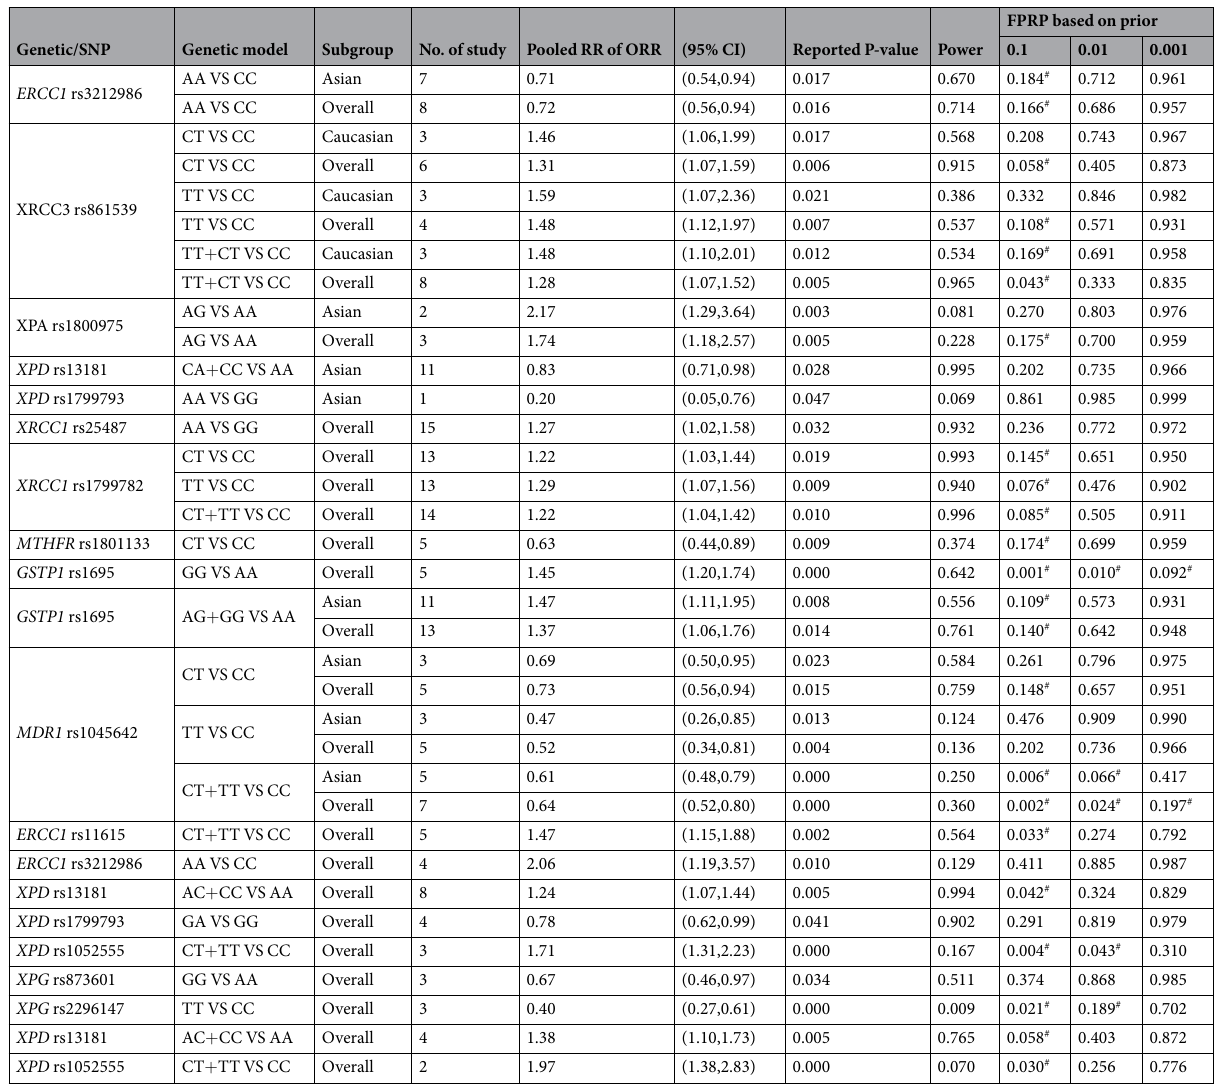
Table 5. FPRP values for the SNPs associated with the response, OS and PFS of NSCLC patients receiving platinum-based chemotherapy. # FPRP value < 0.2.